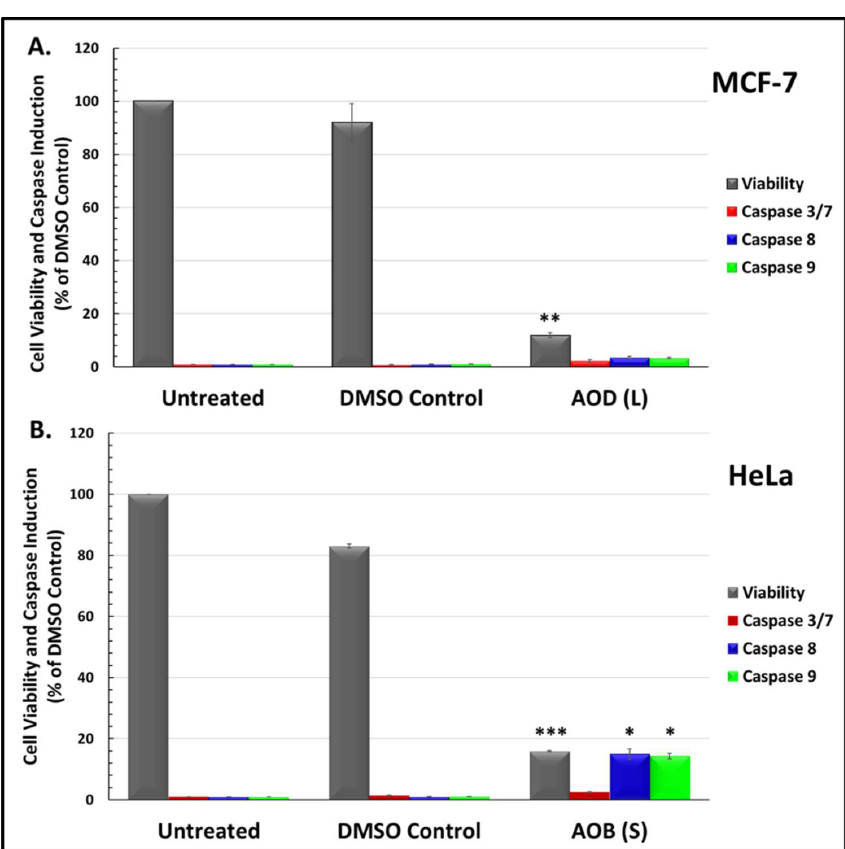
Figure 3. Viability and caspase activity of A. orientalis : ( A ) dichloromethane leaf fraction (AOD (L)) in MCF-7 cells, and ( B ) n-butanol stem fraction (AOB (S)) in HeLa cells treated with 250 µg/mL for 48 h. *, statistically significant differences between the control and treated samples (* p < 0.05; ** p < 0.01 but >0.001; *** p < 0.001). DMSO C, DMSO control having same amount of DMSO as the test treated sample.